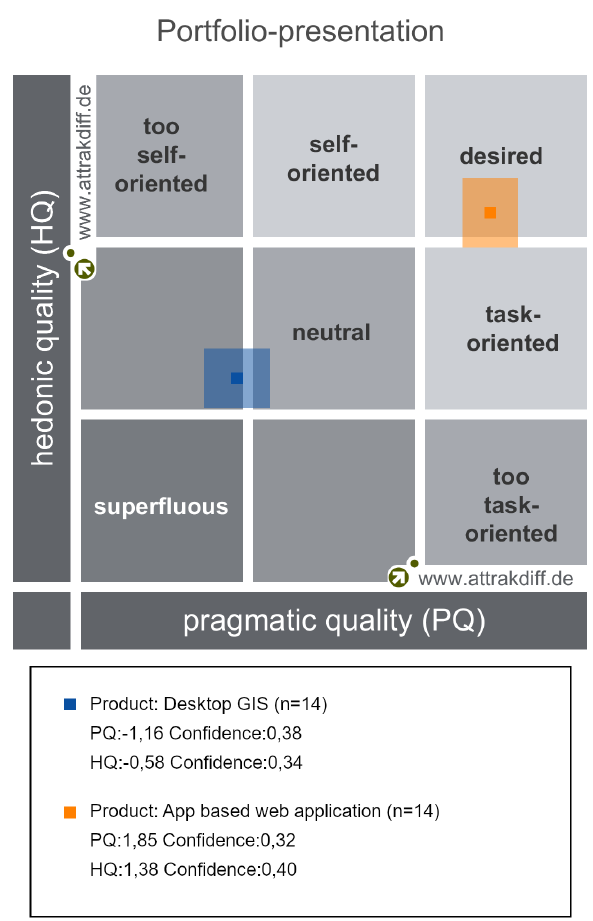
Figure 5. Result of UX-Measurement.